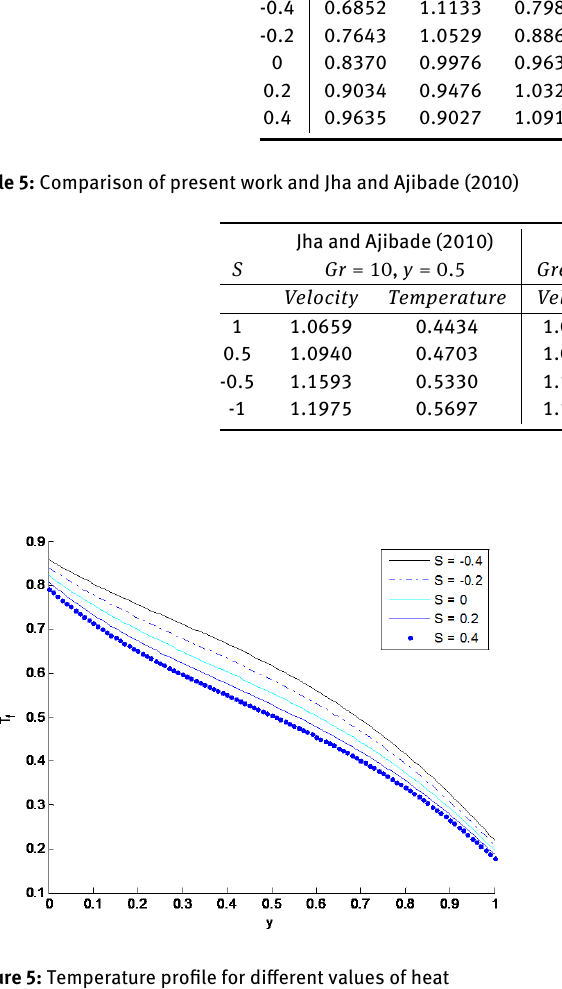
Figure 5: Temperature profile for different values of heat source/sink parameter S ( Br = 0.2 , Gre = 10 , λ = −0.3 , ε = −0.3 , d = 0.2 , q = 1 )